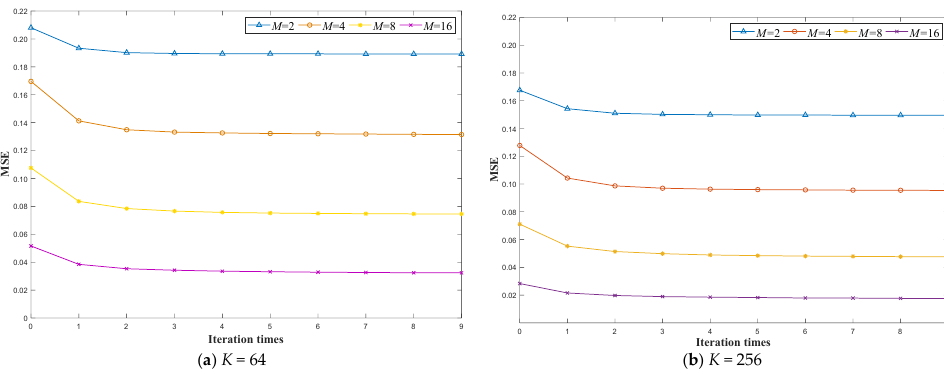
Figure 3. The convergence of training codebooks on SIFT-1M.